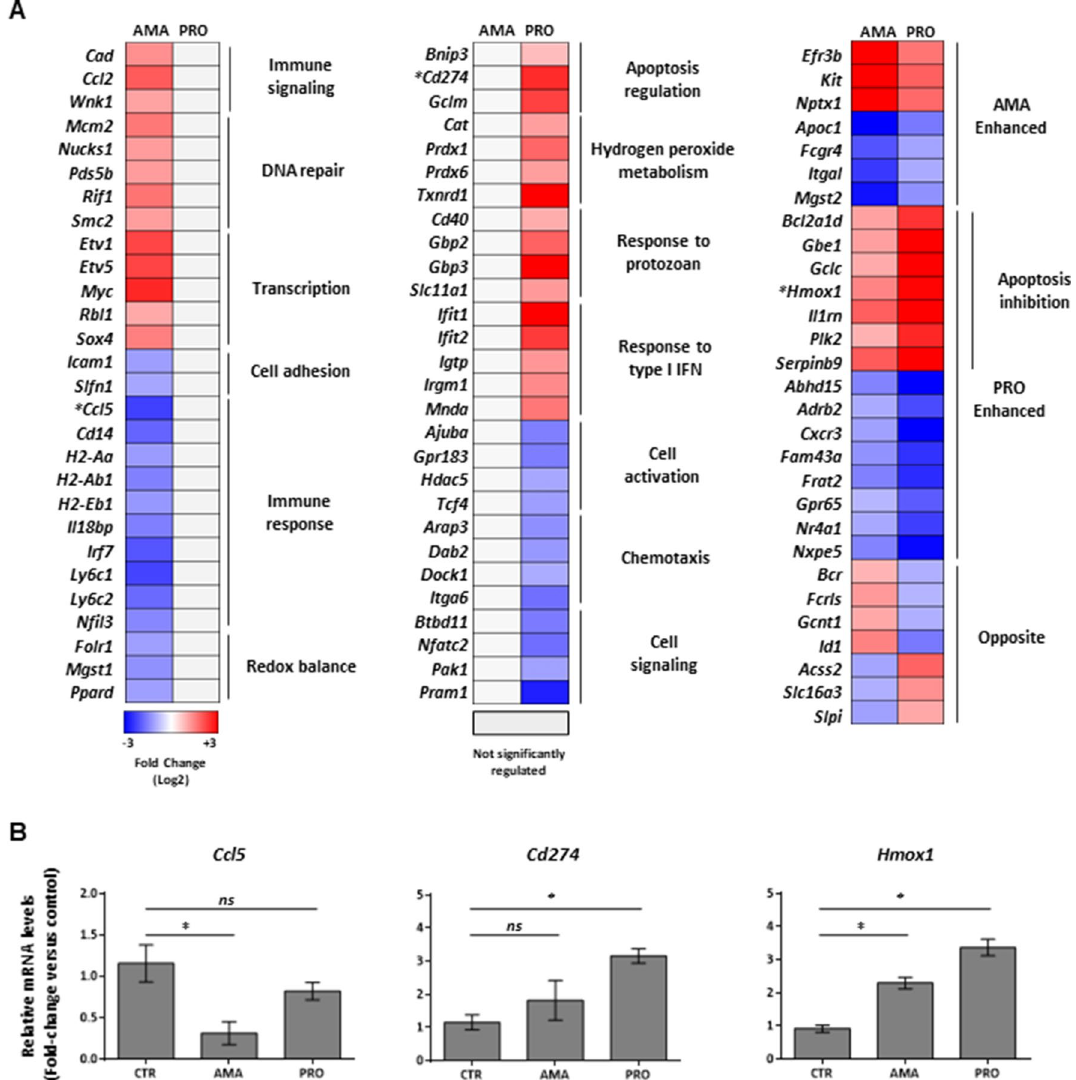
Figure 5. Parasite stage-driven modulation of macrophage transcripts encoding functionally related proteins during L. donovani infection . ( A ) Heatmaps of selected transcripts differentially regulated only by amastigotes (left panel), promastigotes (middle panel) or both (right panel). Manually curated ontology groups are shown for stage-specific regulated transcripts (left and middle panels). Analyses were carried out on data generated from at least three biological replicates. *Targets selected for validation by RT-qPCR. ( B ) Relative mRNA amounts of Ccl5 , Cd274 , and Hmox1 (normalized to Actb ) were measured by RT-qPCR. Data are presented as mean ± SD (biological replicates, n = 3). *p < 0.05 (for the indicated comparisons), ns